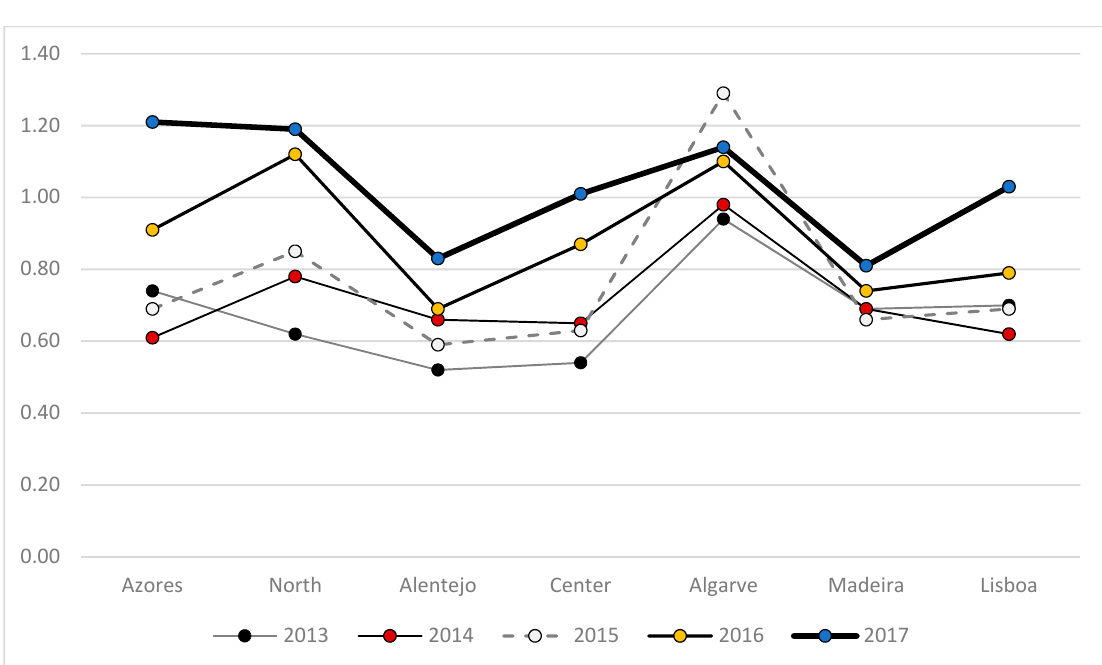
Figure 4. Quick Ratio, by NUT II regions.